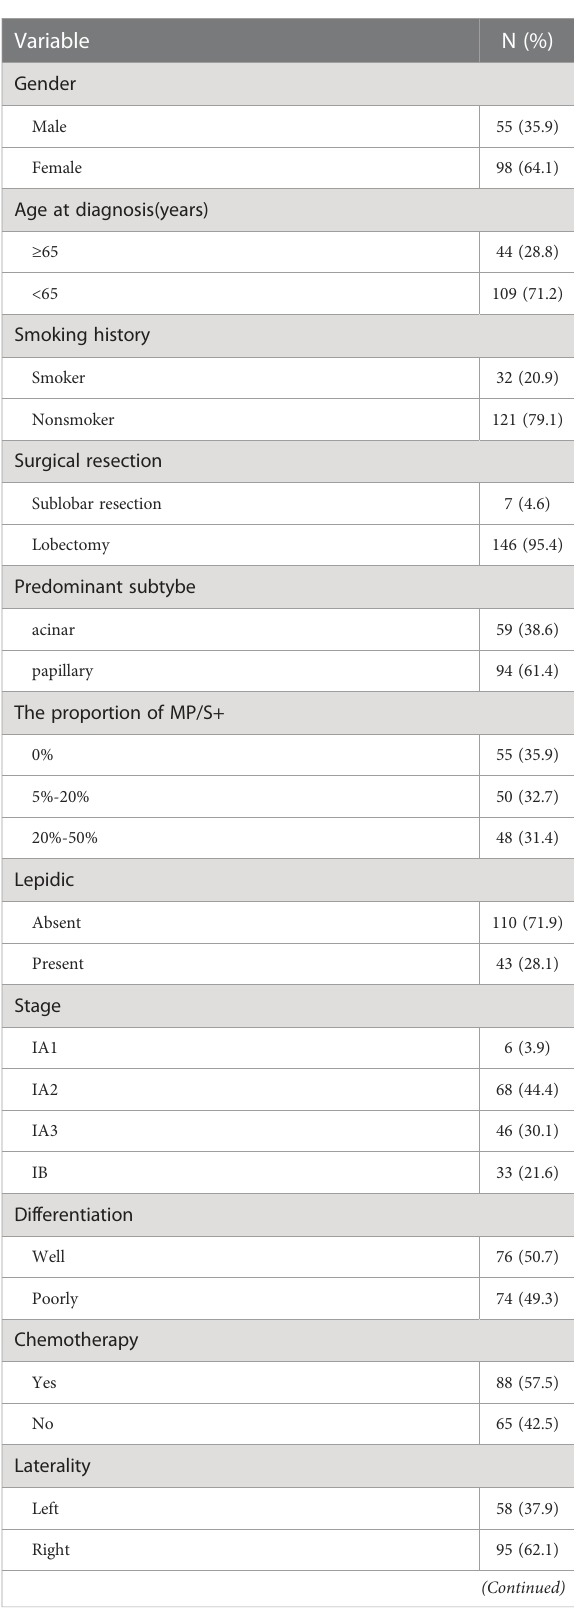
TABLE 1 Clinicopathological characteristics of patients with stage I lung